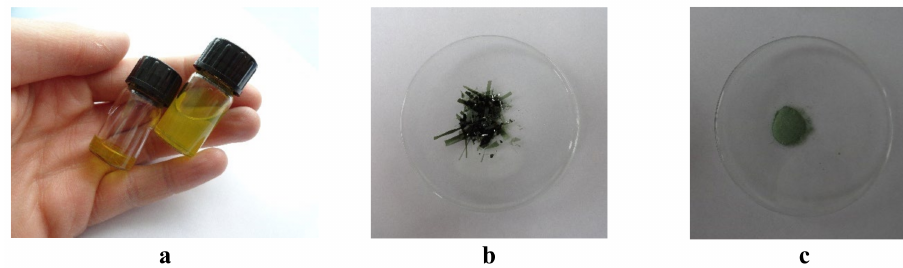
Figure 1. WO 3 sol and gel: ( a ), xerogel ( b ) and powder ( c